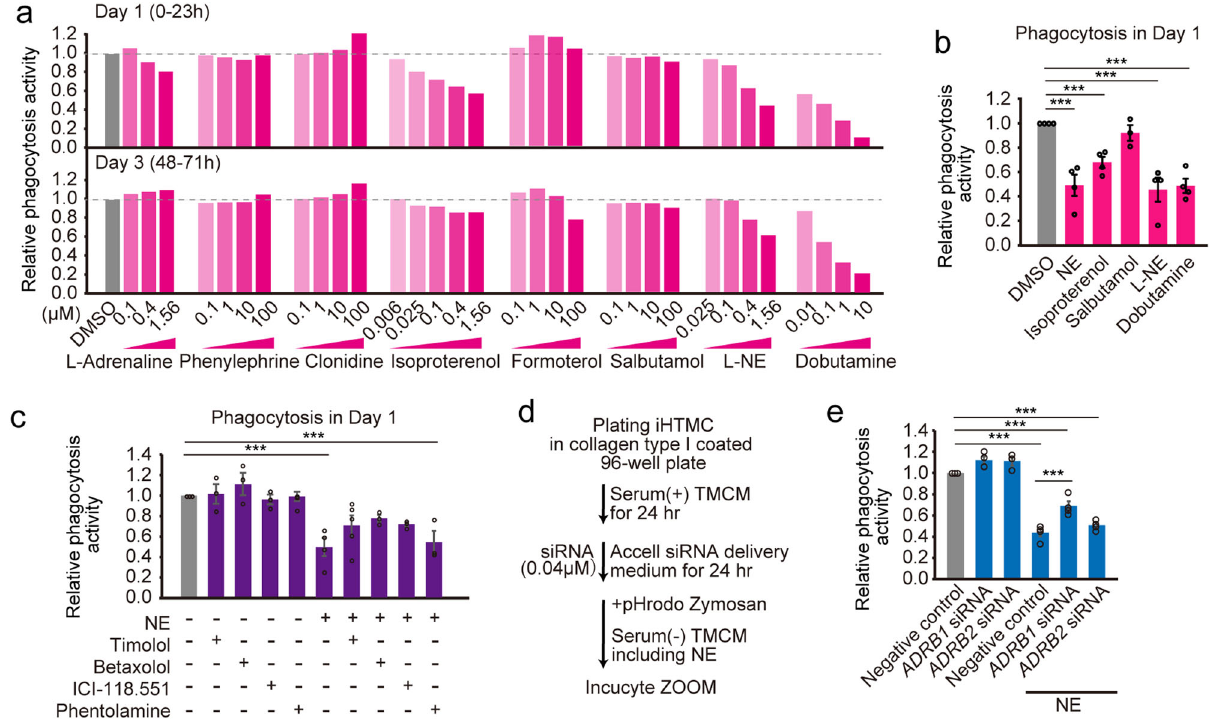
Fig. 4 β 1-adrenergic receptor (AR) mainly attenuated phagocytosis in iHTMC. a Effects of adrenergic receptor (AR) agonists on immortalized human TM cell (iHTMC) phagocytosis for 3 days. Data are presented as the mean ( n = 1; quadruple experiment). Phagocytosis activities were normalized to the control DMSO. Dose-dependent robust suppression of phagocytosis by AR-agonist L-adrenaline, β 1-AR agonists (L-NE and dobutamine), and β 1 β 2-AR agonist (isoproterenol) for 3 days, and no effect of selective α 1-AR agonist (phenylephrine), direct-acting α 2-AR agonist (clonidine), and β 2-AR agonists (formoterol and salbutamol). b Detailed analysis revealed the signi fi cant suppression of phagocytosis by L-NE, dobutamine, and isoproterenol as well as NE, but not by the β 2-AR agonist salbutamol during day 1 (*** p < 0.001 vs. DMSO, one-way ANOVA [ p < 0.001], Dunnett ’ s multiple comparison). Data are presented as bar graphs (mean ± SEM) with scatter dot plots of independent experiments ( n = 4). c AR antagonists timolol ( β 1 β 2), betaxolol ( β 1), and ICI- 118.551 ( β 2) simultaneously with NE (5 µ M) tended to rescue NE-suppressed normalized phagocytic activity but not phentolamine ( α -AR antagonist) in iHTMC during day 1 (* p < 0.05, *** p < 0.001, one-way ANOVA [ p < 0.001], Tukey ’ s multiple comparison). Data are presented as bar graphs (mean ± SEM) with scatter dot plots of independent experiments ( n = 3 − 5). d , e Effect of RNA interference on β 1 β 2-AR by siRNA against ADRB1 and ADRB2 on iHTMC phagocytosis. d After 24 h siRNA ( fi nally 0.04 µ M) exposure with accell siRNA delivery medium, media were changed to those containing NE (1 µ M). Data are presented as bar graphs (mean ± SEM) with scatter dot plots of independent experiments ( n = 3 −